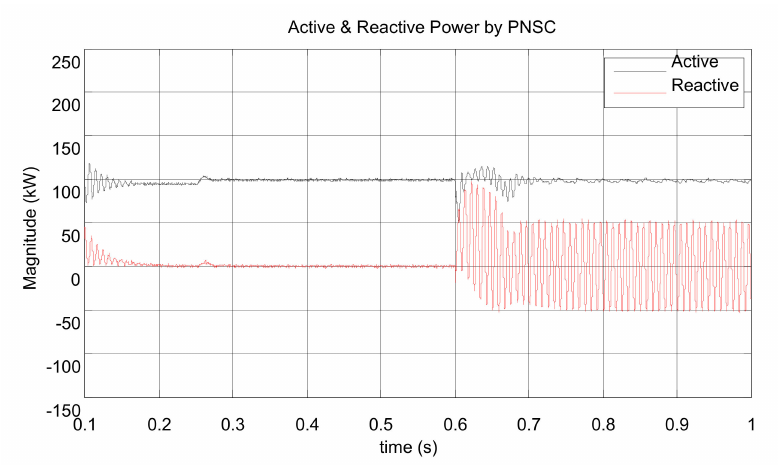
Figure 20. Injected instantaneous power into the grid under ‘type B’ voltage sag.